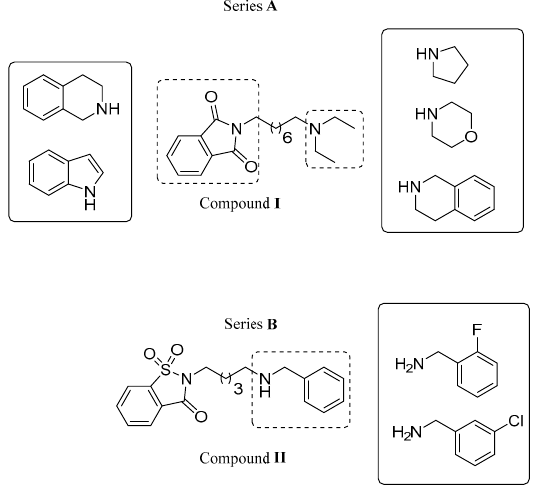
Figure 1. The general structures of the designed compounds.